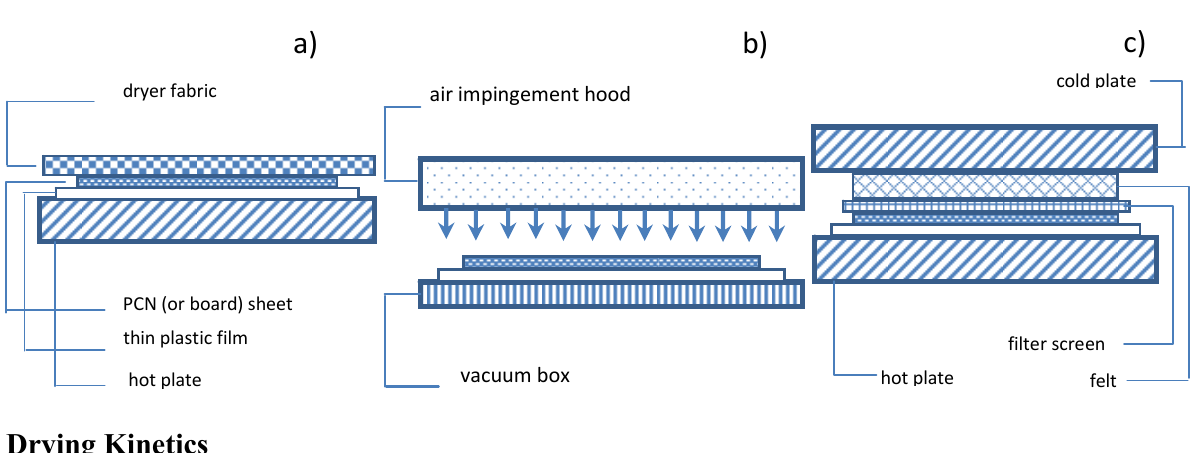
Figure 1. The main components of the studied drying methods: ( a ) contact dryer;